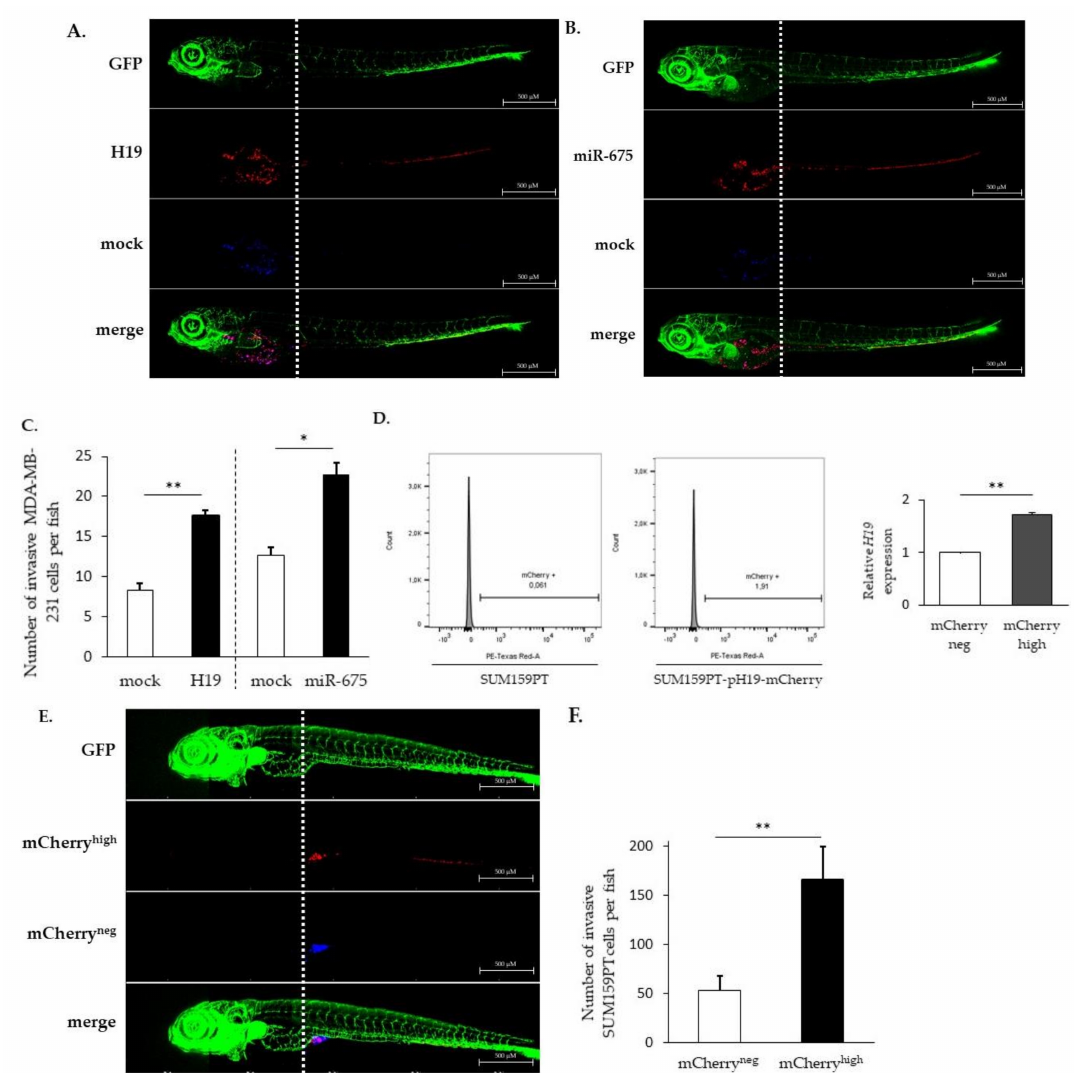
Figure 1. H19 and miR-675 both promote cancer cell invasion in vivo. ( A ) Invasive capacities of MDA-MB-231 stably overexpressing H19 and the control, stained with lipophilic tracers, in transgenic zebrafish. Fluorescent pictures were captured using automated image acquisition software. ( B ) Invasive capacities of MDA-MB-231 stably overexpressing miR-675 and the control, stained with lipophilic tracers, in transgenic zebrafish. Fluorescent pictures were captured using automated image acquisition software. ( C ) Quantification of invasive cells per zebrafish. ( D ) mCherry protein fluorescence in SUM159PT transfected or not with pH19-mCherry plasmid. Fluorescence intensity is categorized in mCherry neg and mCherry high cellular subpopulations. Relative H19 expression in those subpopulations is figured. ( E ) Invasive capacities of mCherry neg and mCherry high cellular subpopulations, stained with lipophilic tracers, in transgenic zebrafish. Fluorescent pictures were captured using automated image acquisition software. ( F ) Quantification of invasive cells per zebrafish. For each experiment, forty embryos were used. * p < 0.05 and ** p <